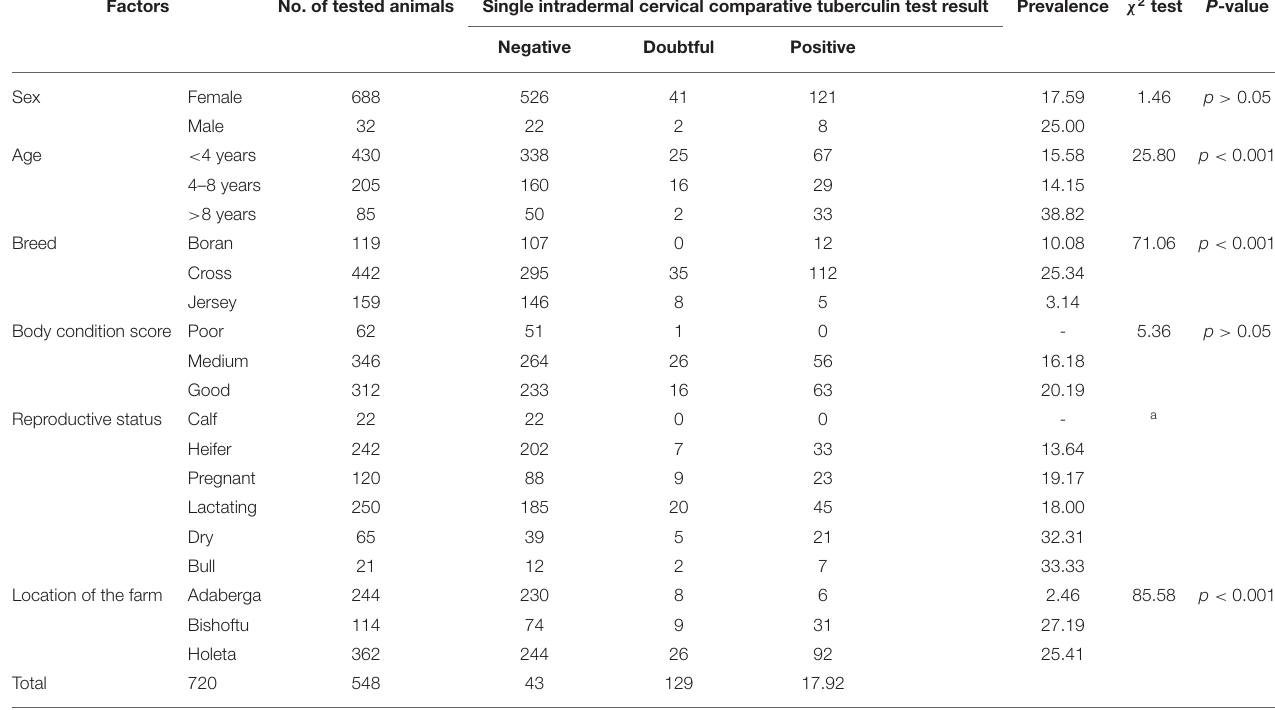
TABLE 2 | Association of different risk factors with the occurrence of bovine tuberculosis in three herds used for the selection of reactors for slaughtering for the investigation of pathology. Factors No. of tested animals Single intradermal cervical comparative tuberculin test